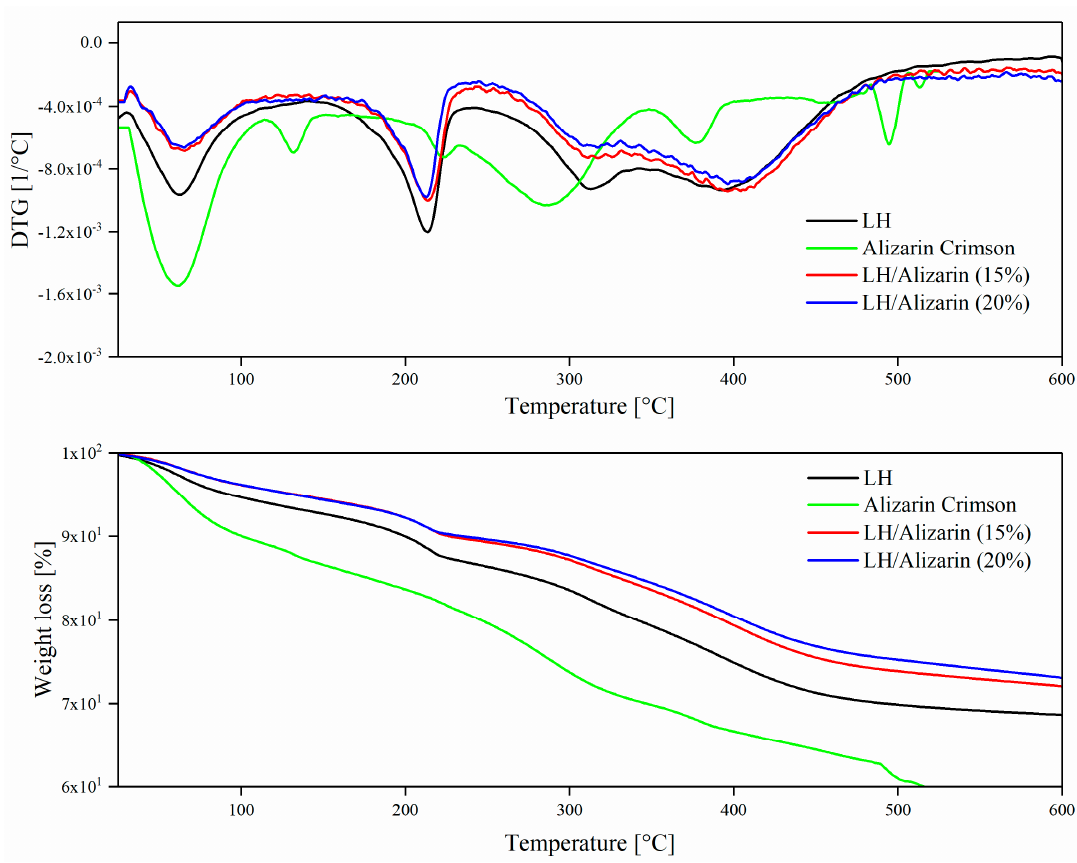
Figure 5. TG/DTG curves for alizarin lake with 10% and 20% alizarin content and Alizarin Crimson.